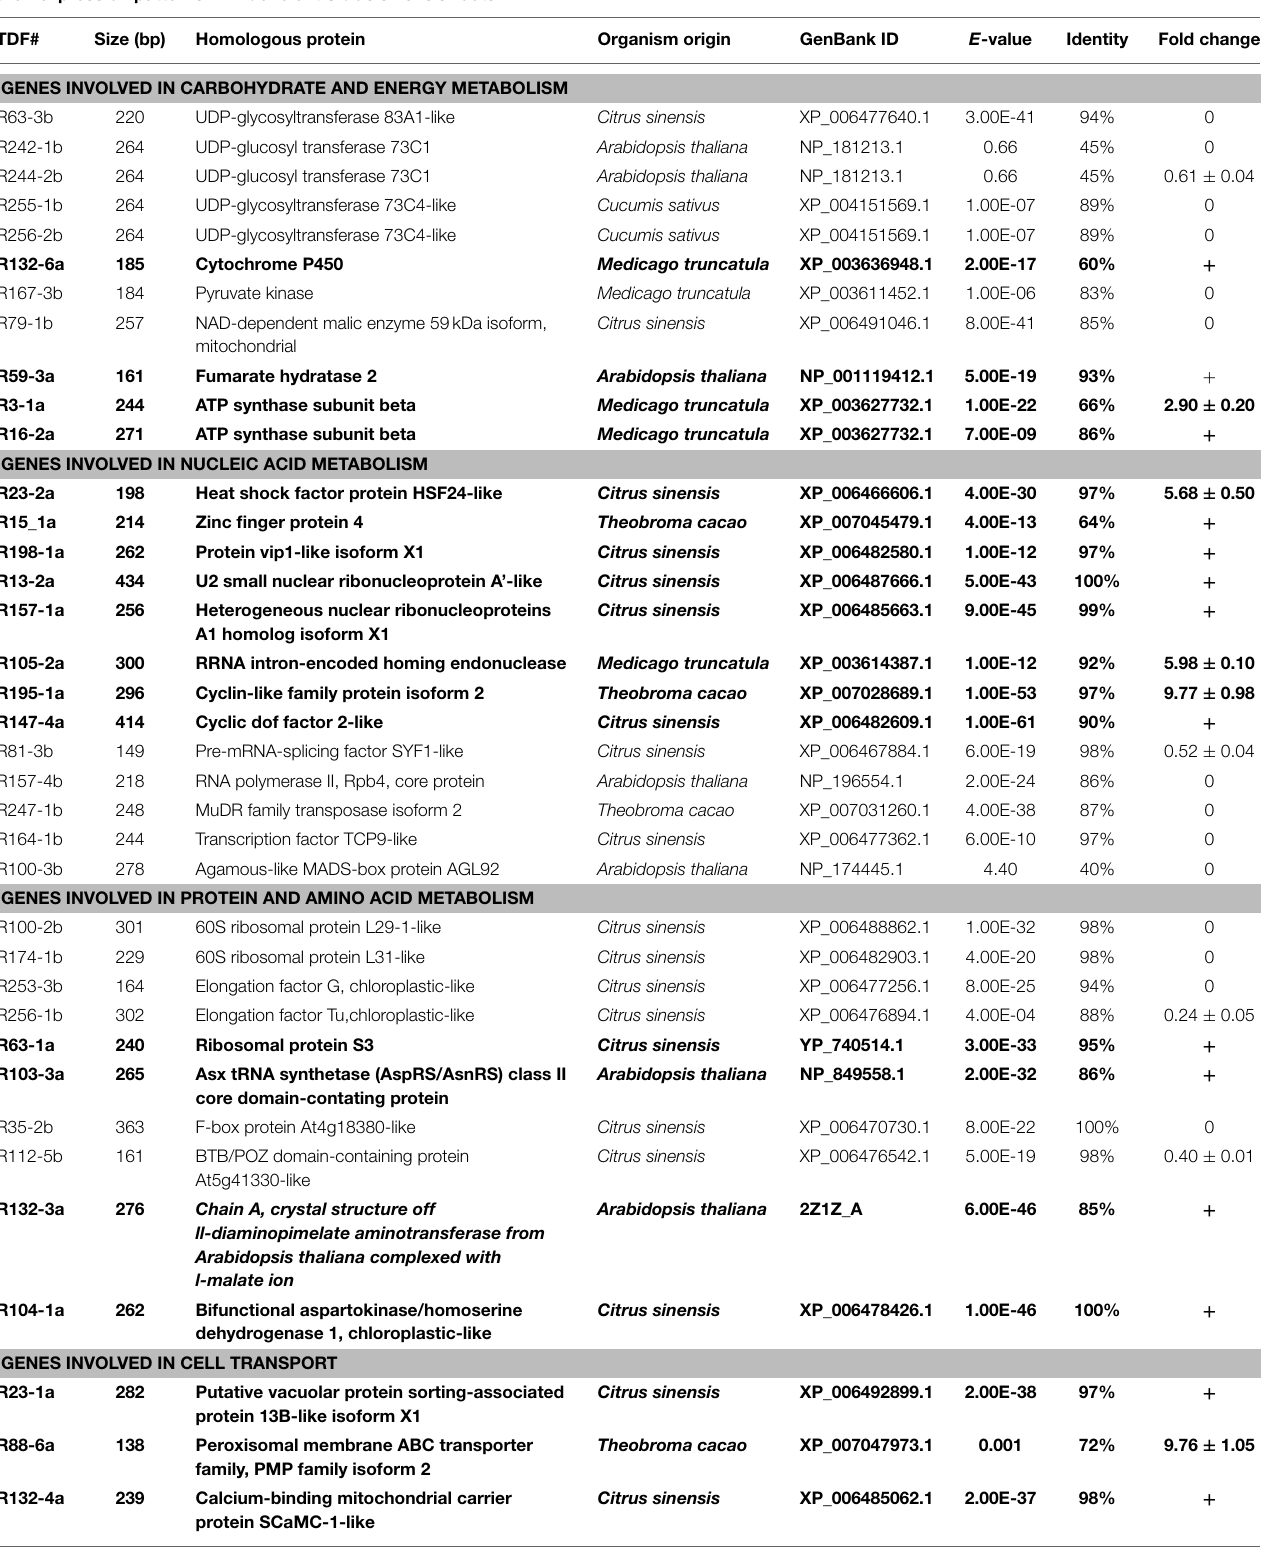
TABLE 1 | Homologies of differentially expressed cDNA-AFLP fragments with known gene sequences in database using BLASTN algorithm along with their expression patterns in B-deficient Citrus sinensis